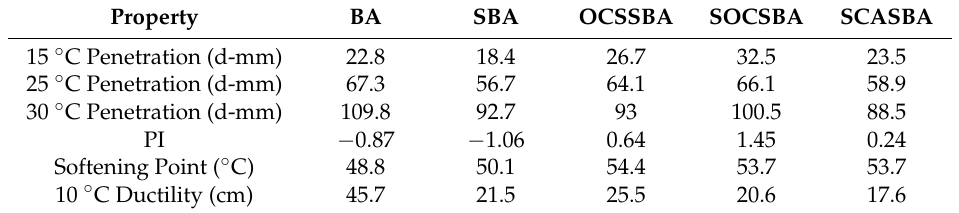
Table 4. The conventional physical properties tests results of BA, SBA, OCSSBA, SOCSBA, and SCASBA. Property BA SBA OCSSBA SOCSBA SCASBA